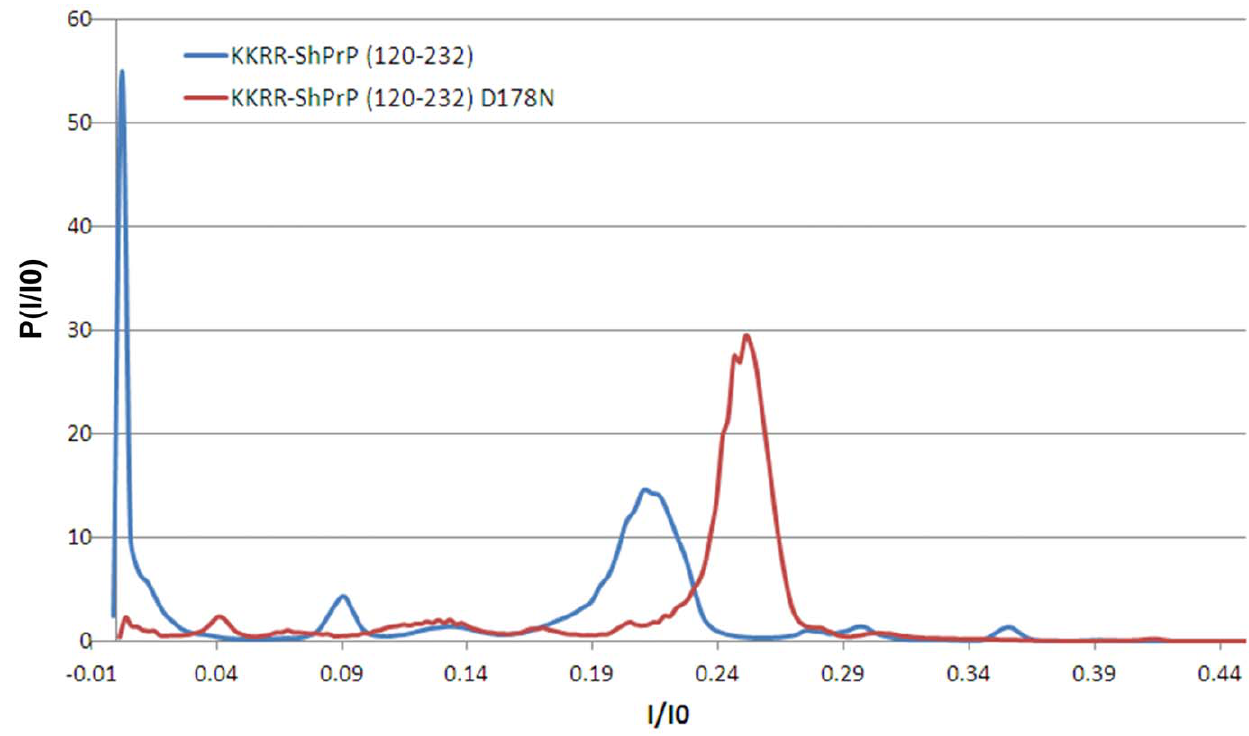
Figure 3. All-point current histogram for KKRR-ShPrP(120–232) and KKRR-ShPrP(120–232)-D178N. Ionic current histogram of all PrP C capture events from all voltages, with ionic current normalized by the open-pore current (I0) at a given voltage, for KKRR-ShPrP(120–232) (blue) and KKRR-ShPrP(120–232)-D178N (red). Ionic current is median filtered to 2.99 ms per data-point. The histograms exhibit multiple peaks with varying degrees of overlap indicative of complex PrP C kinetics in the pore. Moreover, the histograms exhibit clear distinguishable features (e.g. the near absence of the peak at I/I0 , 0 pA with respect to KKRR-ShPrP(120–232)-D178N).